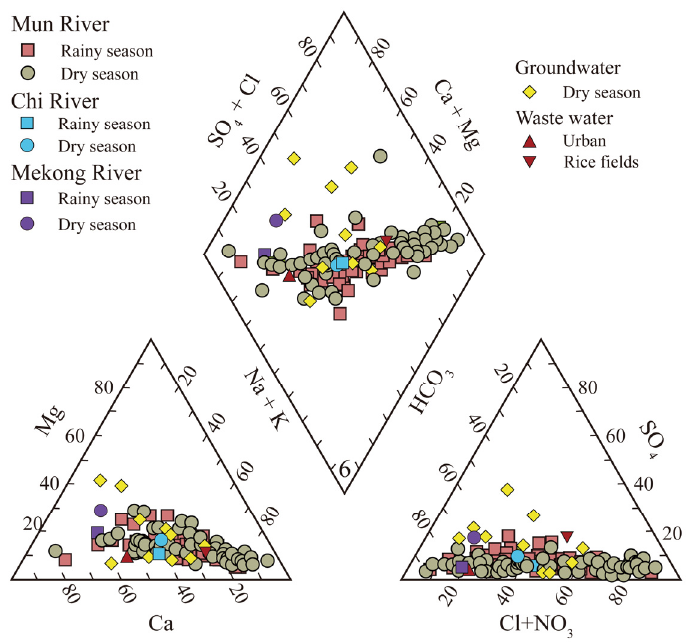
Figure 2. Piper graph of river water in the Mun River.